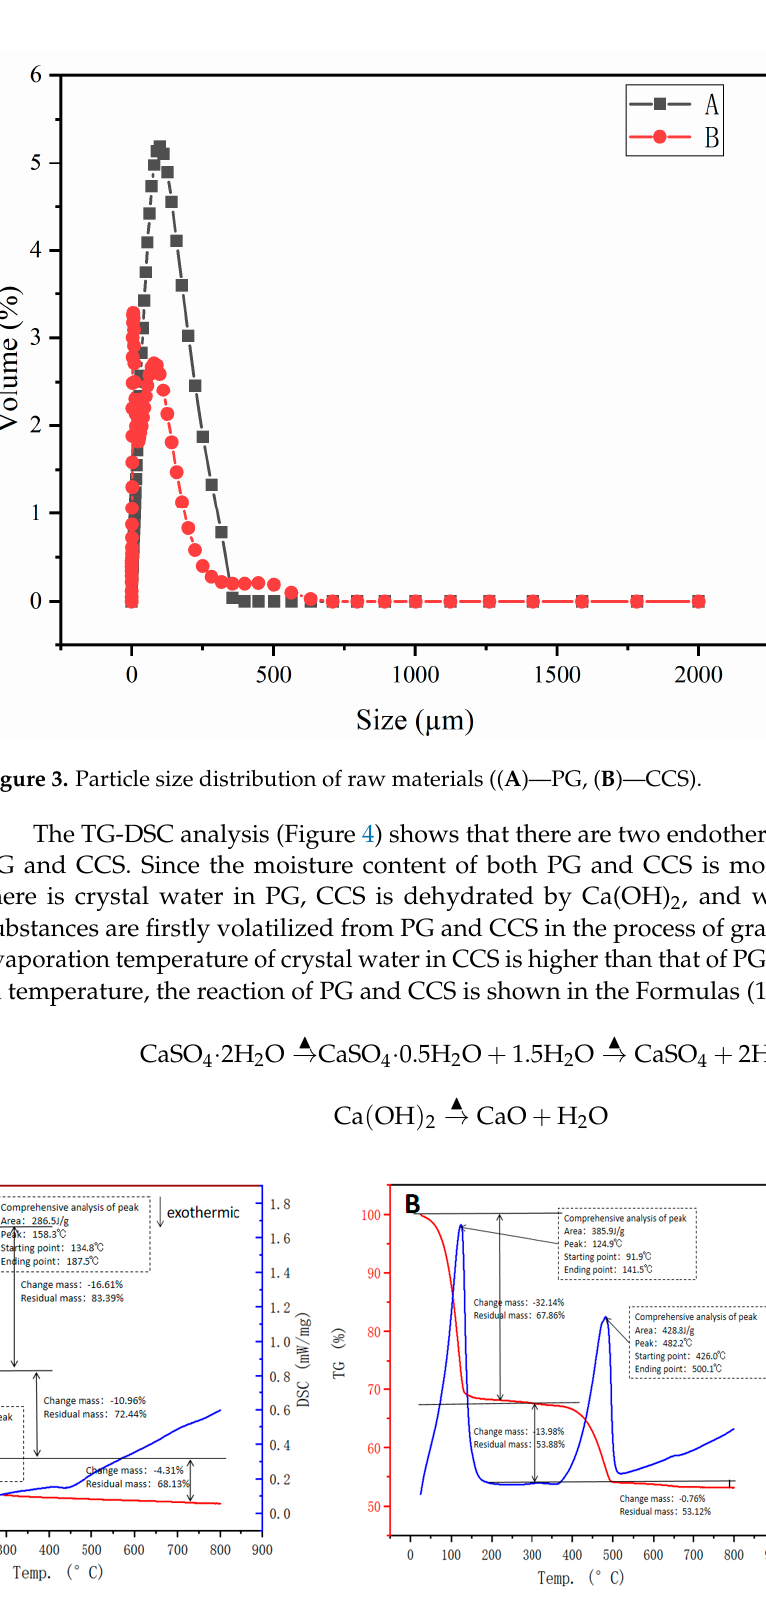
Figure 4. TG-DSC of raw materials ( A -PG, B -CCS).